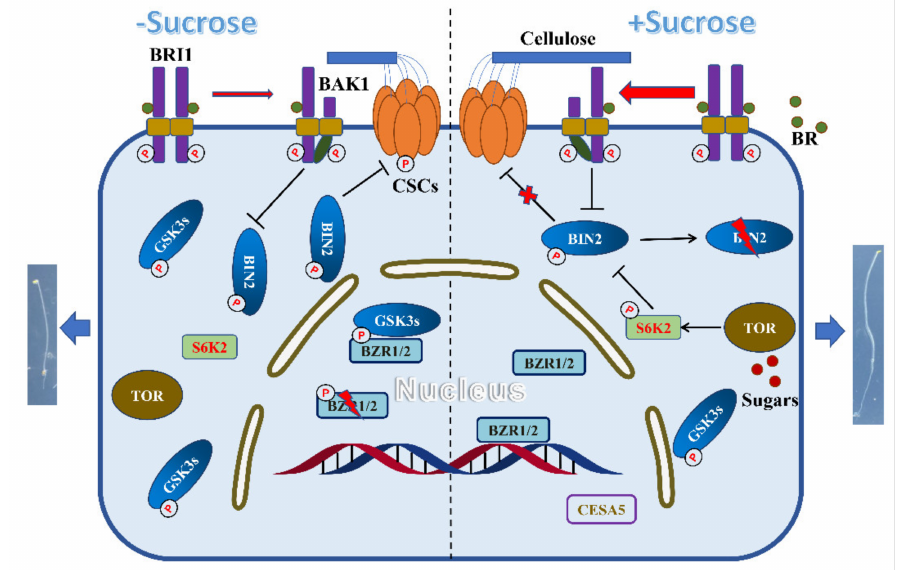
Figure 7. A model for sucrose-promoted skotomorphogenesis in the dark. The model illustrates the mechanisms whereby exogenously supplied sugar enhances brassinosteroid (BR) biosynthesis [29], the interaction between BRI1 and BAK1 [42], and the activation of the TOR-S6K2 pathway, resulting in the inhibition of GSK3 kinases and the enhancement of BIN2 degradation. Inactivation of BIN2 and its homologs leads to the accumulation of BZR1/2 for transcriptional regulation (including the upregulated expression of CESA genes [48]) and the enhancement of CESA complex activity [50] for cellulose synthesis, which may synergistically promote skotomorphogenesis in the